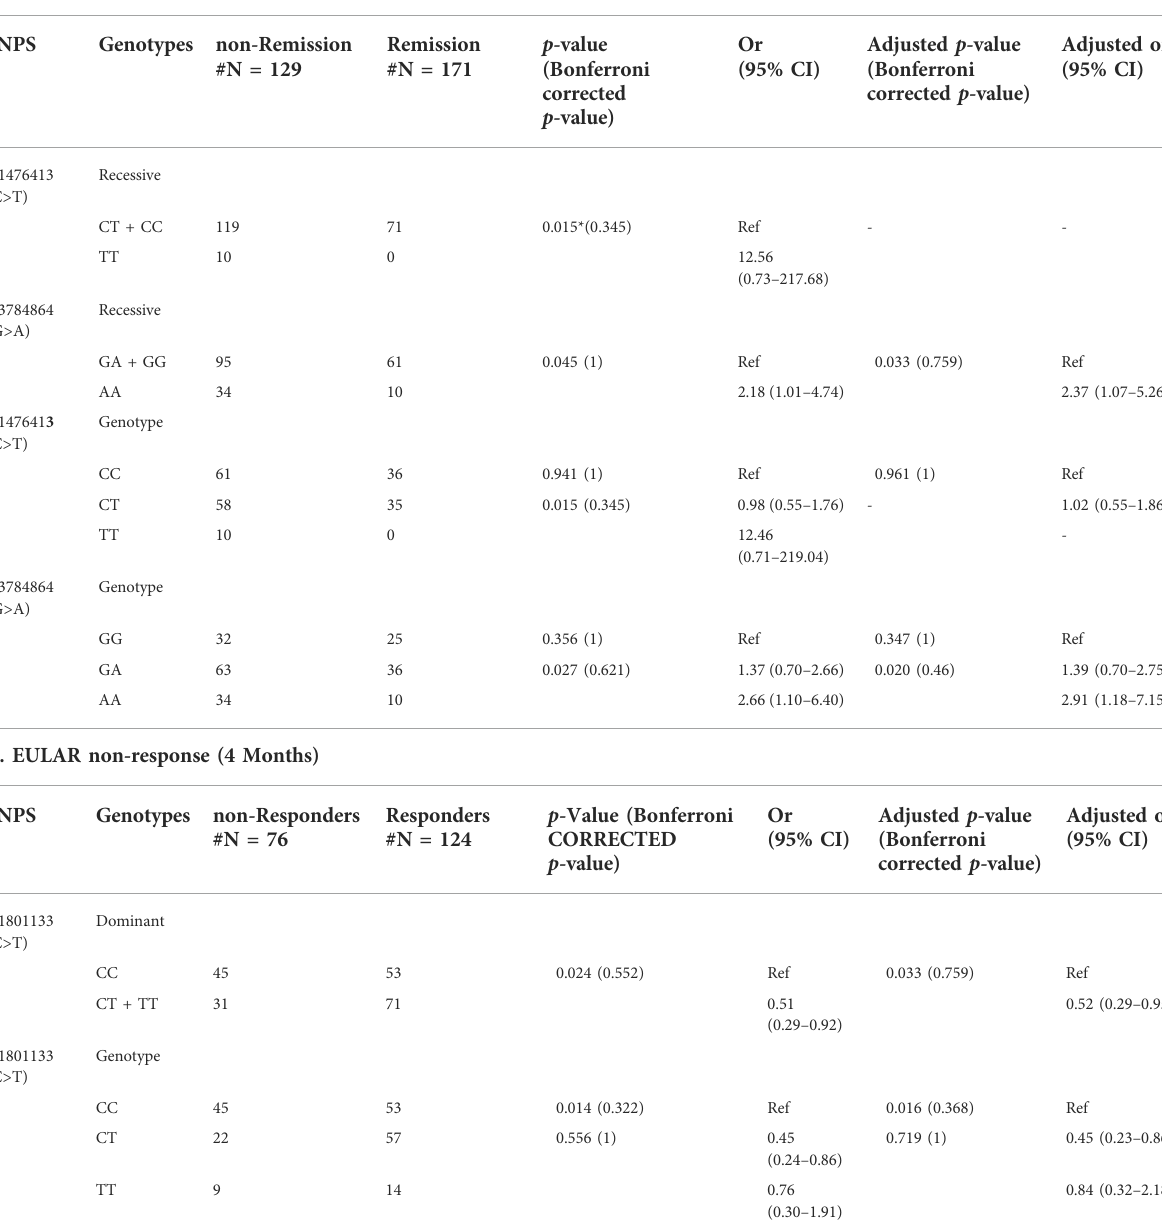
TABLE 3 SNPs associated with MTX treatment inef fi ciency measured by categorical